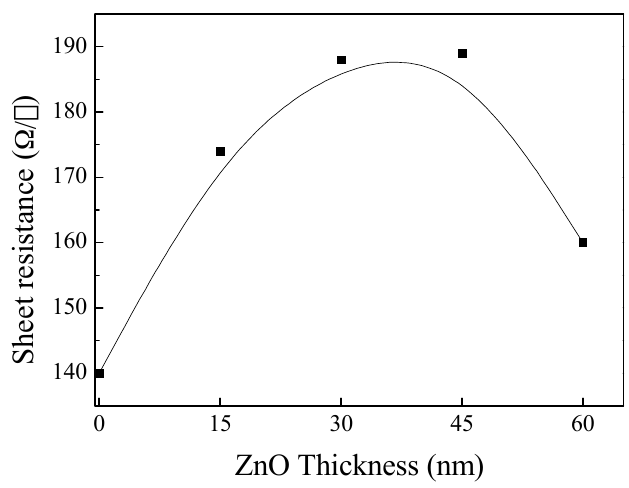
Figure 25. The sheet resistance of ZnO/Cu 2 S/ZnO/glass complex films for different thickness.